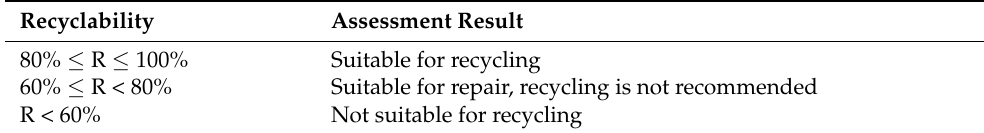
Table 1. The recovery feasibility evaluation of household energy storage.